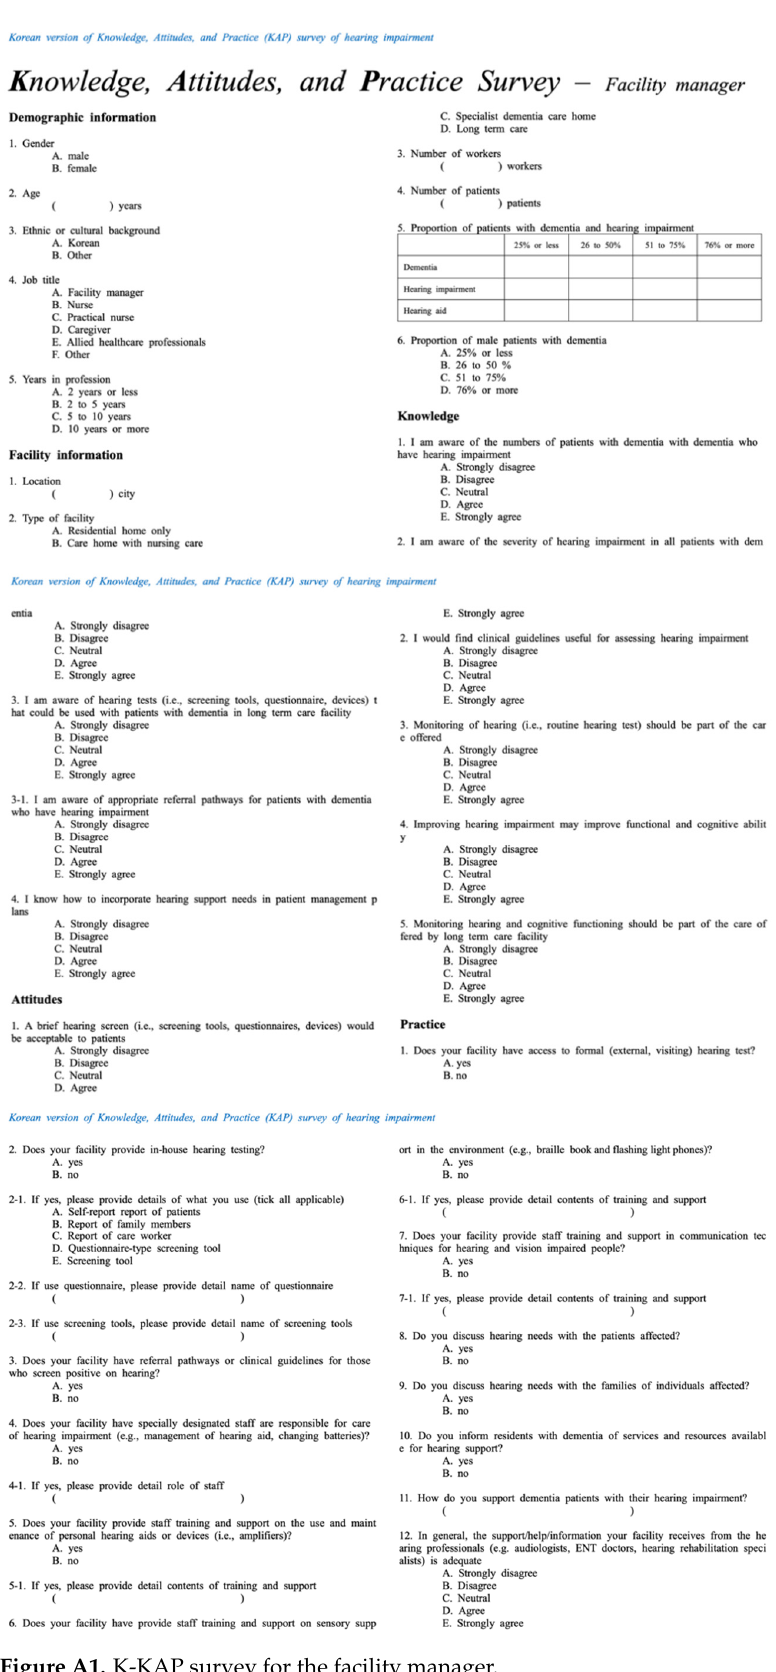
Figure A1. K-KAP survey for the facility